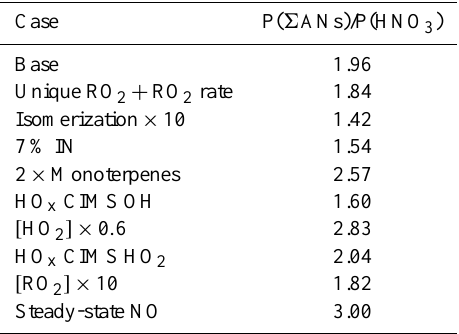
Table A2. The median value of the P( 6 ANs) to P(HNO 3 ) ratio and the speciation of P( 6 ANs) for different assumptions regarding RO 2 reaction rates, OH and HO 2 concentrations, and VOC concentra- tions as described in Appendix